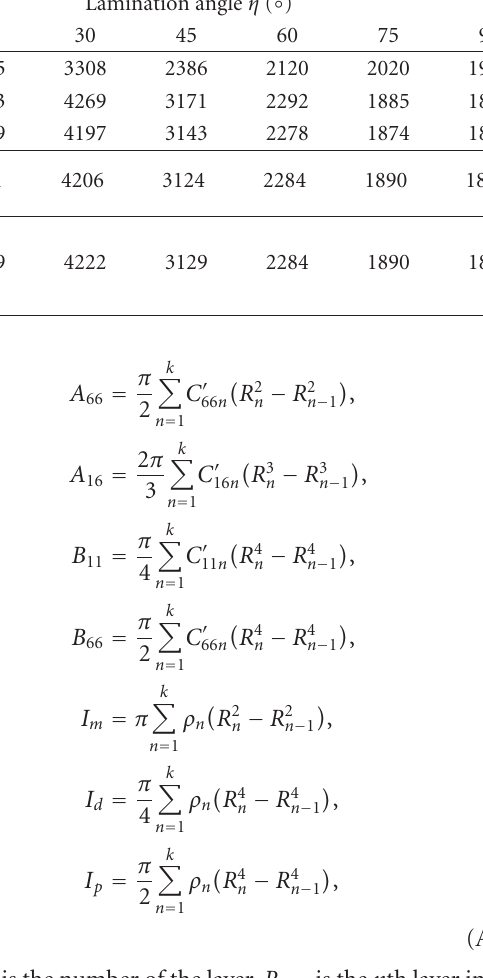
Table 5: The critical speed (rpm) of the graphite-epoxy composite shaft for various lamination angles. Theory or